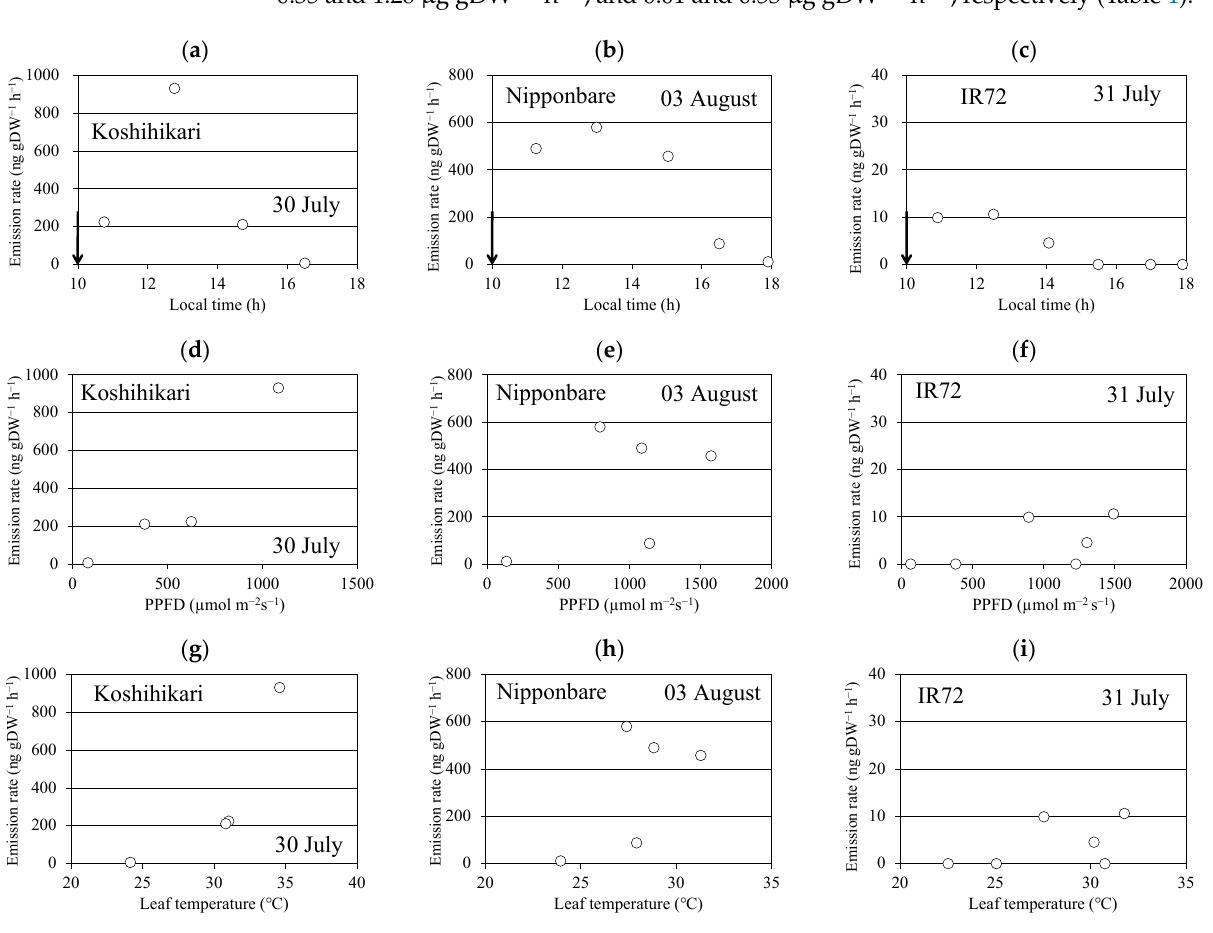
Figure 1. Time course of the emission rate of linalool ( a – c ), and its relationships with photosynthetic photon flux density (PPFD) ( d – f ) and leaf temperature ( g – i ). Black arrow indicates the time when the aboveground parts of the rice plant were enclosed in the bag.